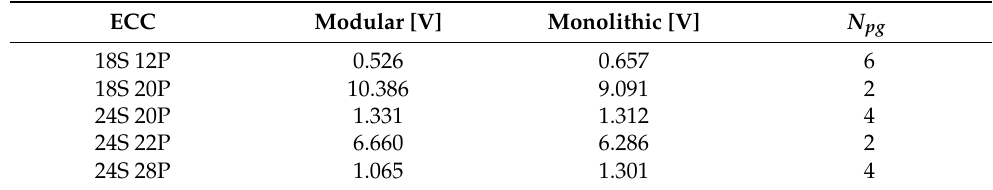
Table 15. Maximum back-emf unbalance for different PMSM and MPMSM slot/pole combinations in the presence of DE.